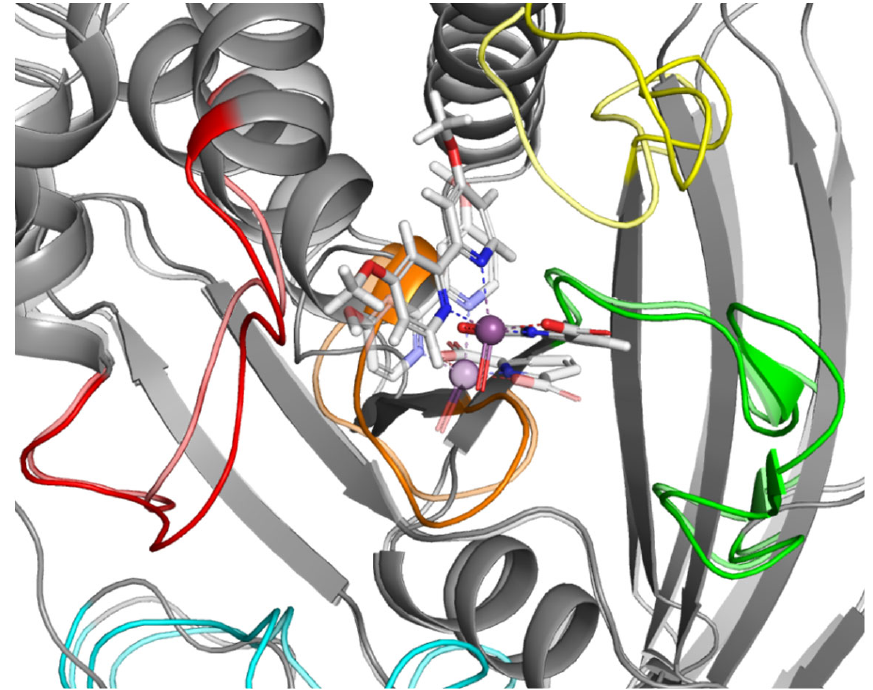
Figure 8. Result of MD simulation of Compound 4 (white sticks) and the PTP1B complex (1ONZ). Transparent structures presents a studied complex on start of simulation and filled structures present position after 50 ns. Significant loops are highlighted with separate colors; P-loop in orange, WPD-loop in yellow, E-loop in green, and Q-loop in red.